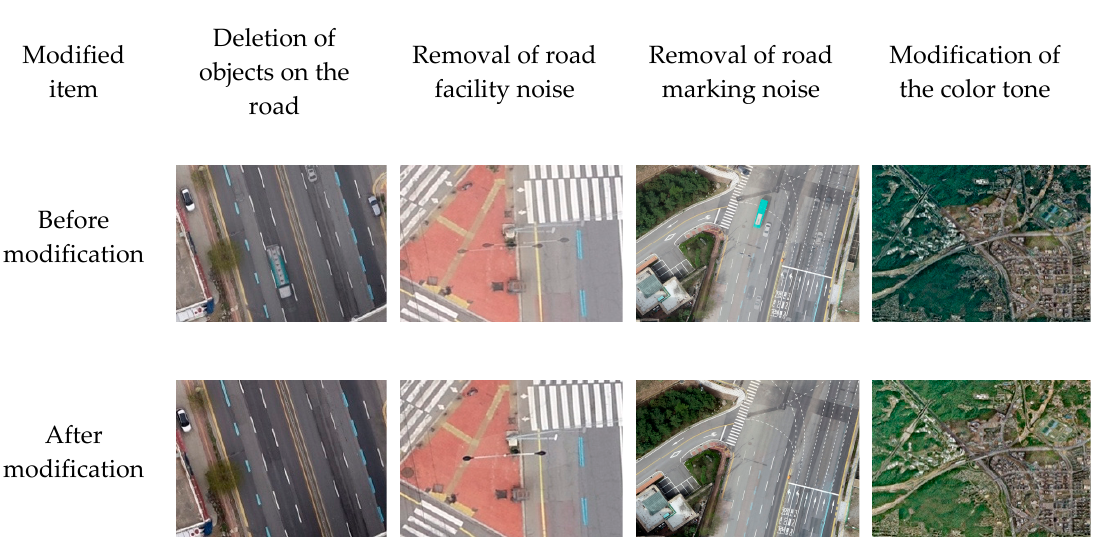
Table 2. Stages of map dissemination levels.